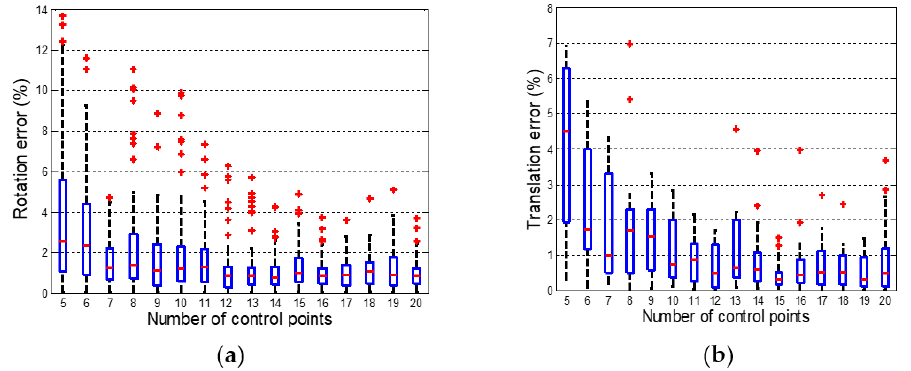
Figure 4. Pose estimation errors for different numbers of control points. ( a ) Rotation matrix error ( b ) Translation vector error.